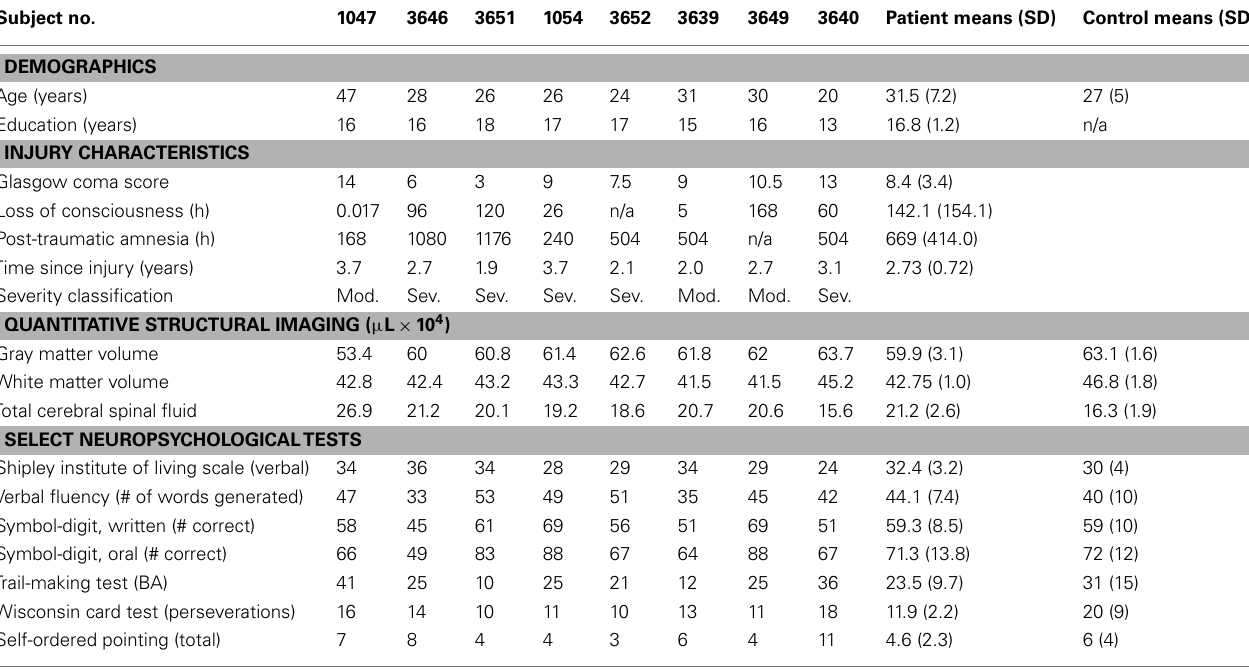
Table 1 |Traumatic brain injury patient demographics, acute injury characteristics, structural neuroimaging data, and neuropsychological test